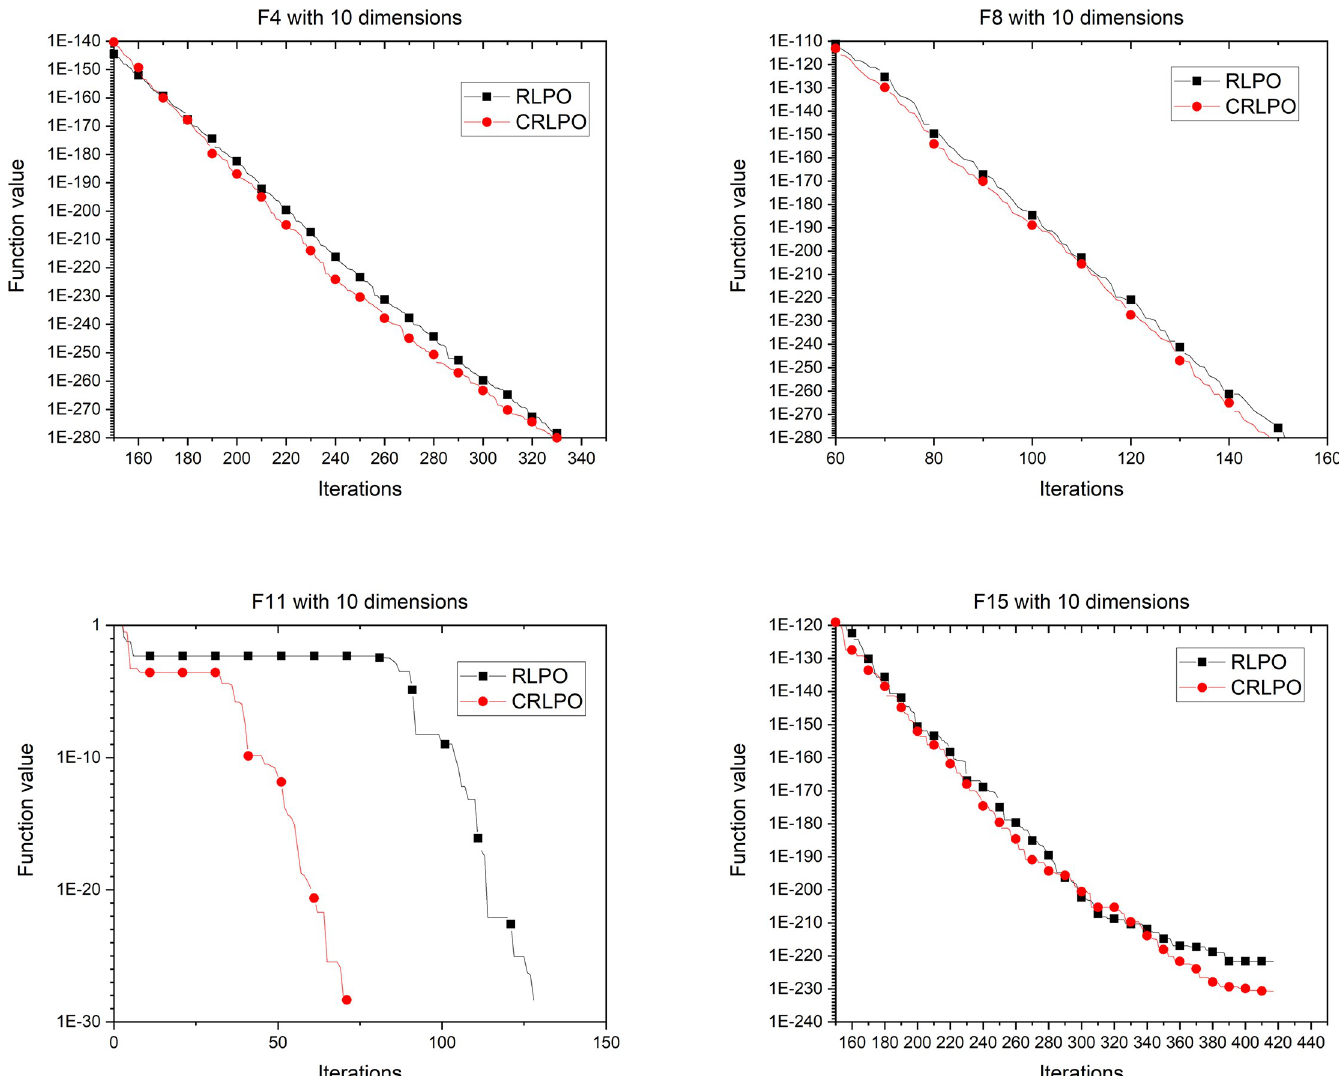
Fig 11. Convergence graph of CRLPO on 4 representative benchmark functions with 10